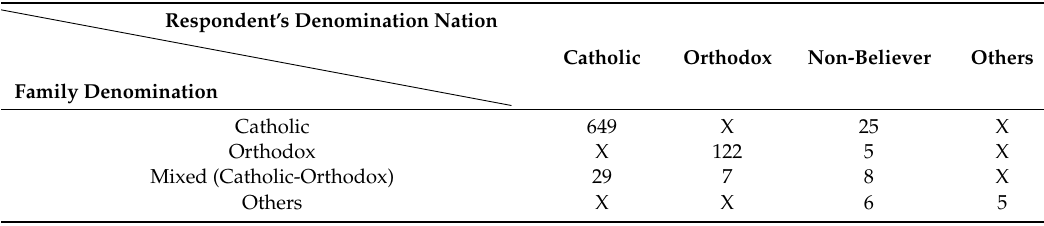
Table 3. Religious structure of the studied population by family